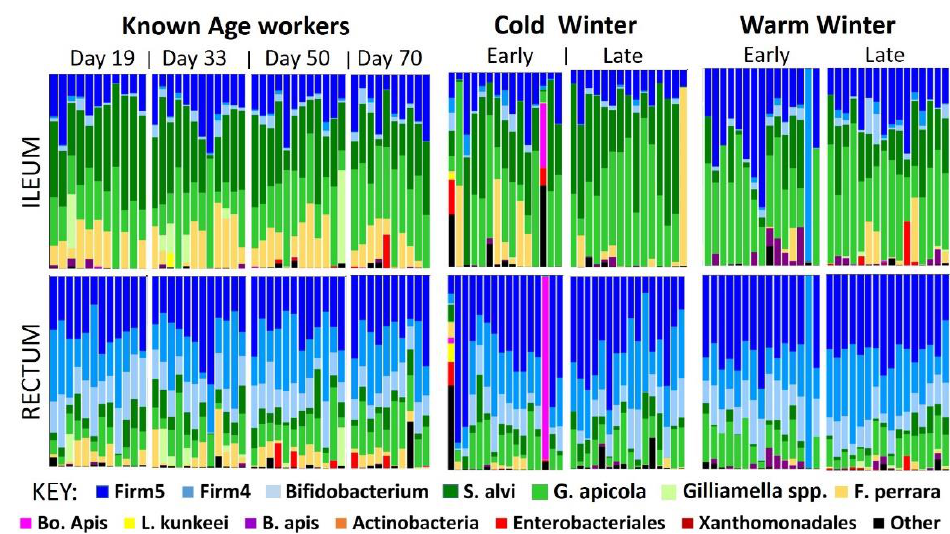
Figure 1. Bar charts representing the relative bacterial structure of each individual ileum and rectum. Known age (KA) samples ( n = 47) were taken at 19, 33, 50, and 70 days of age from observation hives kept at Carl Hayden Bee Research Station AZ USA. The cold winter results are from 16 colonies sampled before and after 7 °C cold storage for 3 months in a large, climate controlled agricultural warehouse in Firth, ID, USA. Warm winter results are from 16 colonies kept outdoors at a warm southern location, with forage access near Green Valley, AZ, USA. Bacterial OTUs are identified by their respective color presented in the figure key. See supplementary material for more information.